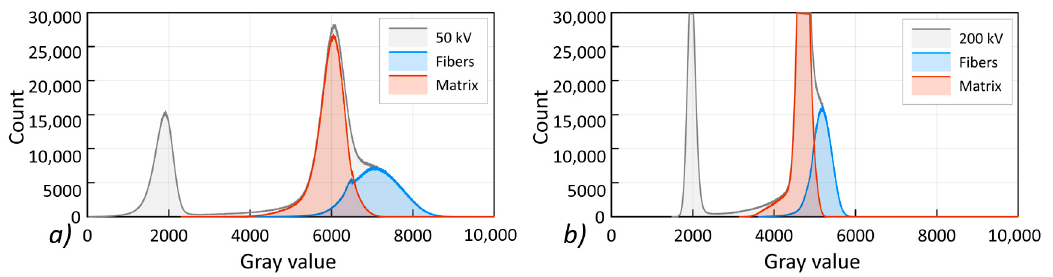
Figure 10. Grayscale histograms recorded for the PP reconstruction with X-ray tube voltage: ( a ) 50 kV, ( b ) 200 kV.